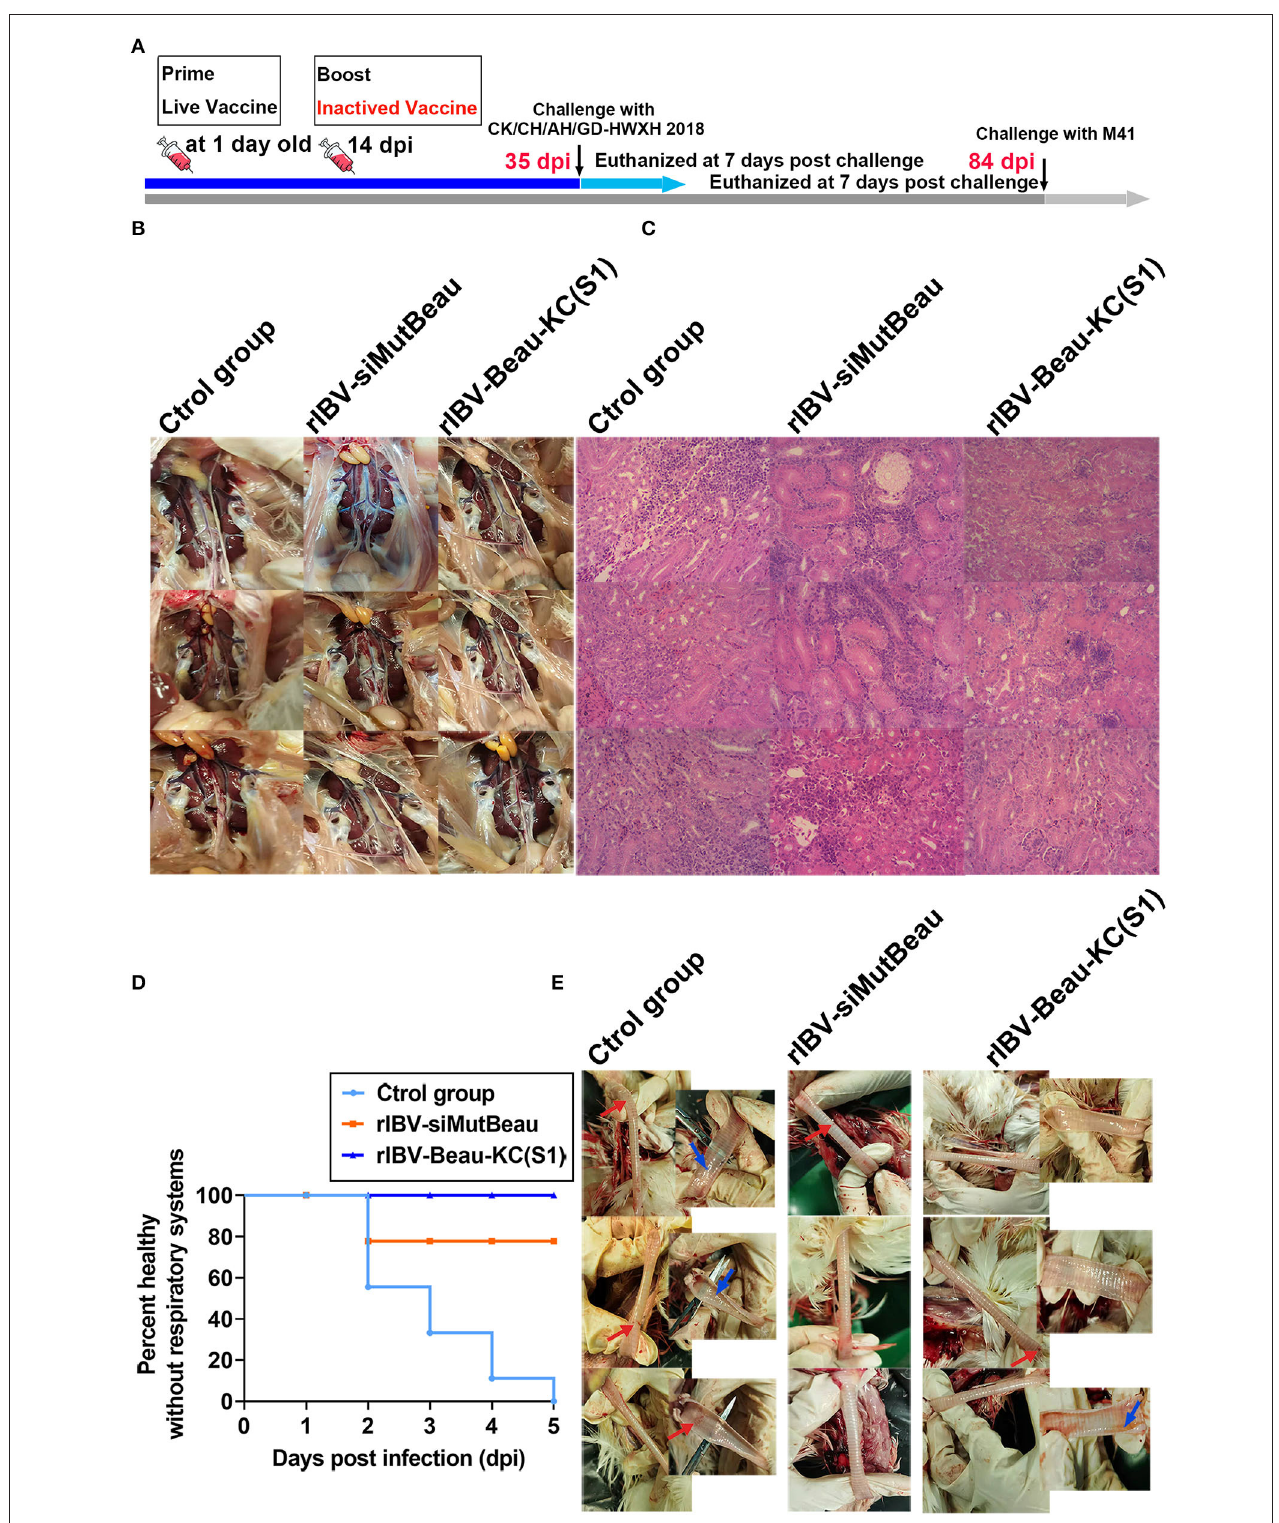
FIGURE 6 | Cross-protection against CK/CH/JS/TAHY and M41. (A) Immunization and challenge protocol. One-day-old chicks ( n = 15/group) were prime-immunized with a dose of 10 5 EID 50 rIBV-Beau-KC(S1) live vaccine by nasal-ocular route, and were boost-immunized intramuscularly with a dose of 10 5 TCID 50 rIBV-Beau-KC(S1)-inactivated vaccine at 14 days. The same doses of rIBV-siMutBeau and PBS were used as control, and CK/CH/JS/TAHY and M41 challenges